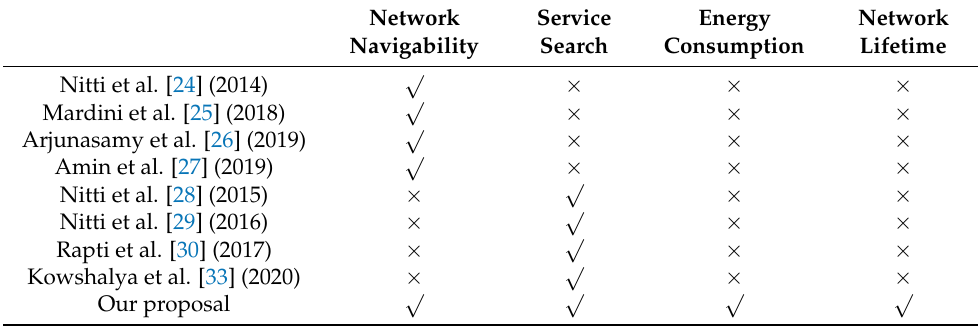
Table 1. Functional comparison of our proposal work with the previous